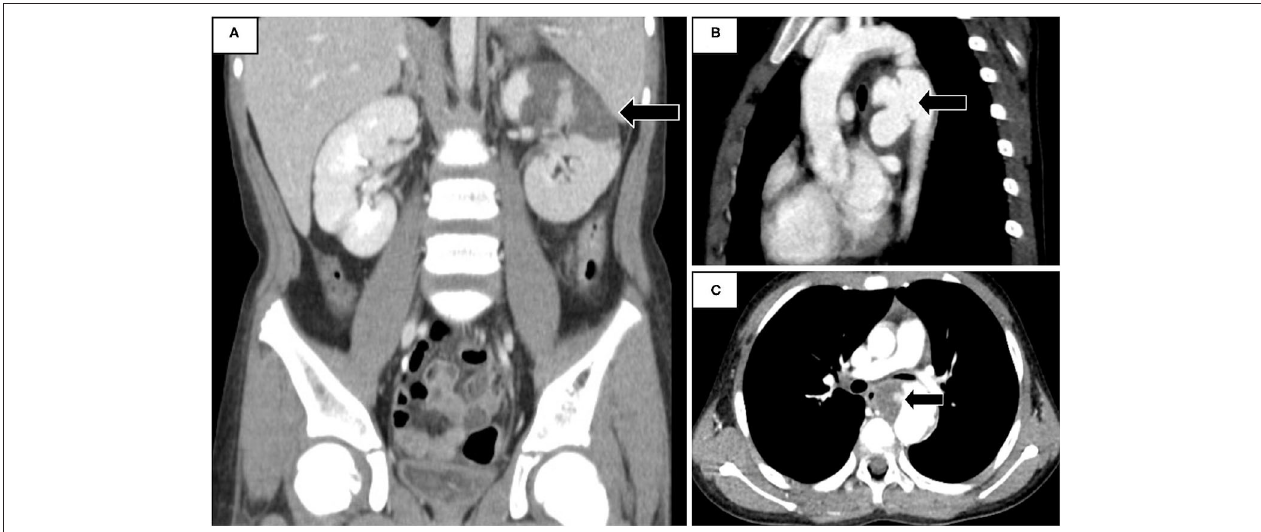
FIGURE 1 | (A) Abdominal Computed tomography (CT) revealed infarction in left kidney. (B) CT angiogram demonstrated a coarcted aneurysm at the descending aorta. (C) Complicated intra-aneurysmal mural thrombus formation with